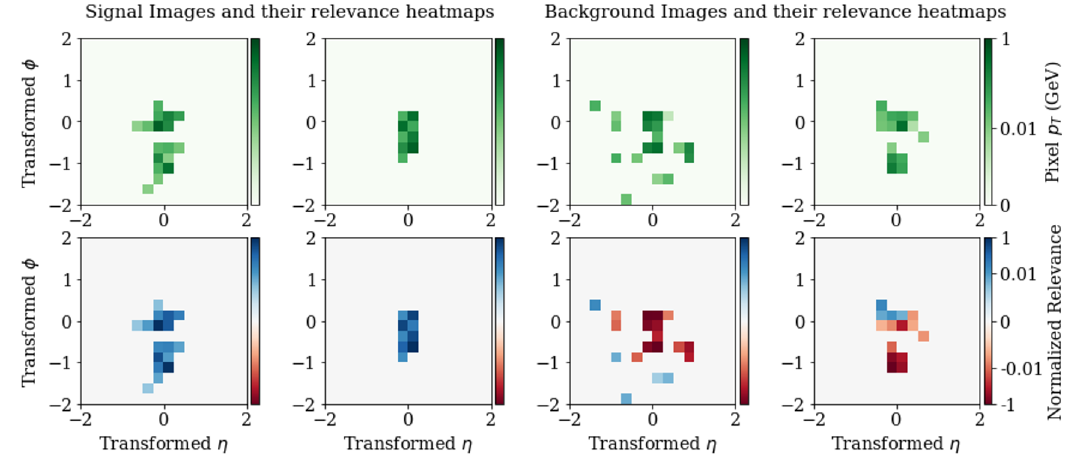
Figure 19. Individual Particle Model signal (left two columns) and background (right two columns) images (top) and their corresponding LRP score heatmaps (bottom).